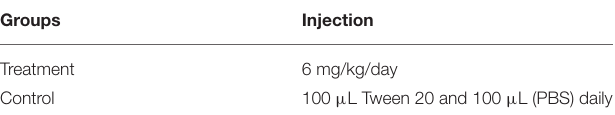
TABLE 1 | In vivo experiment intraperitoneally (IP) injection of treatment (ethanol extract) and control groups. Groups